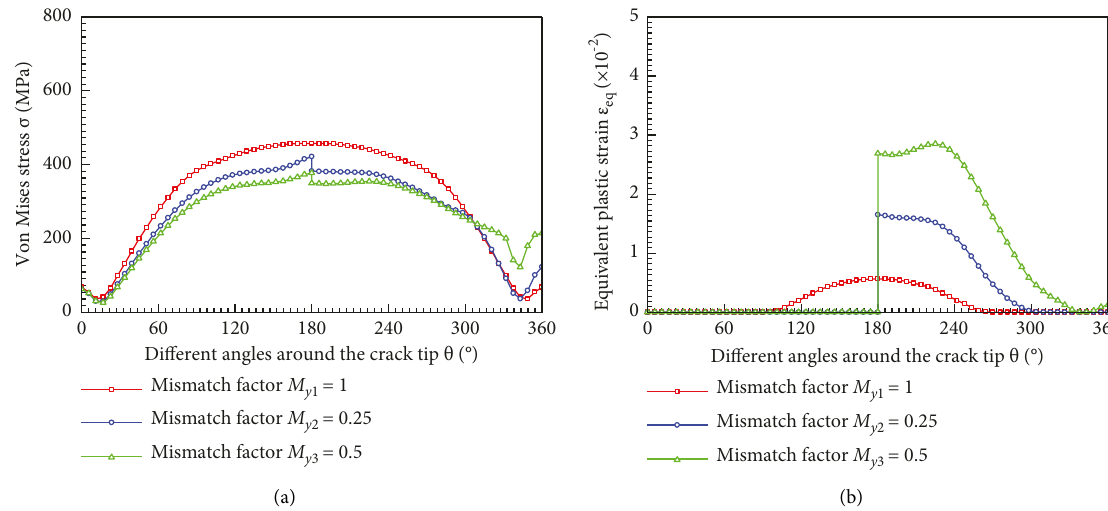
Figure 9: Curve of the sandwich structure welded joint model whose yield strength changes in the y -direction. (a) Von Mises stress curve at crack tip. (b) Equivalent plastic strain curve at crack